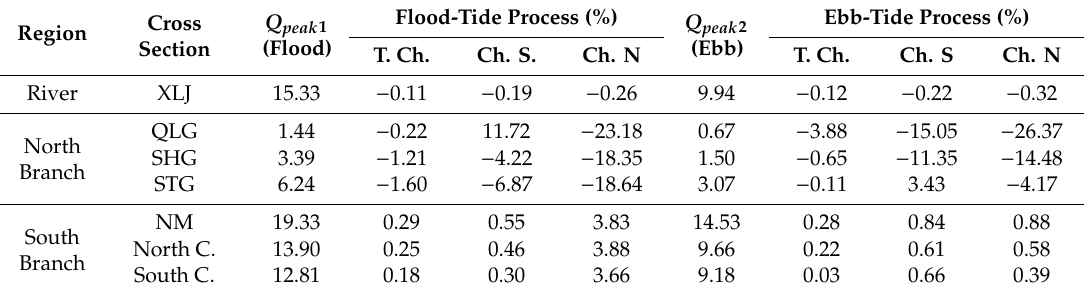
Table 3. Variations of cross-sectional discharge peaks ( Q peak ) in the estuary after GYS Regulation. Flood-Tide Process (%) Q peak 1 Cross Region (Flood) Section